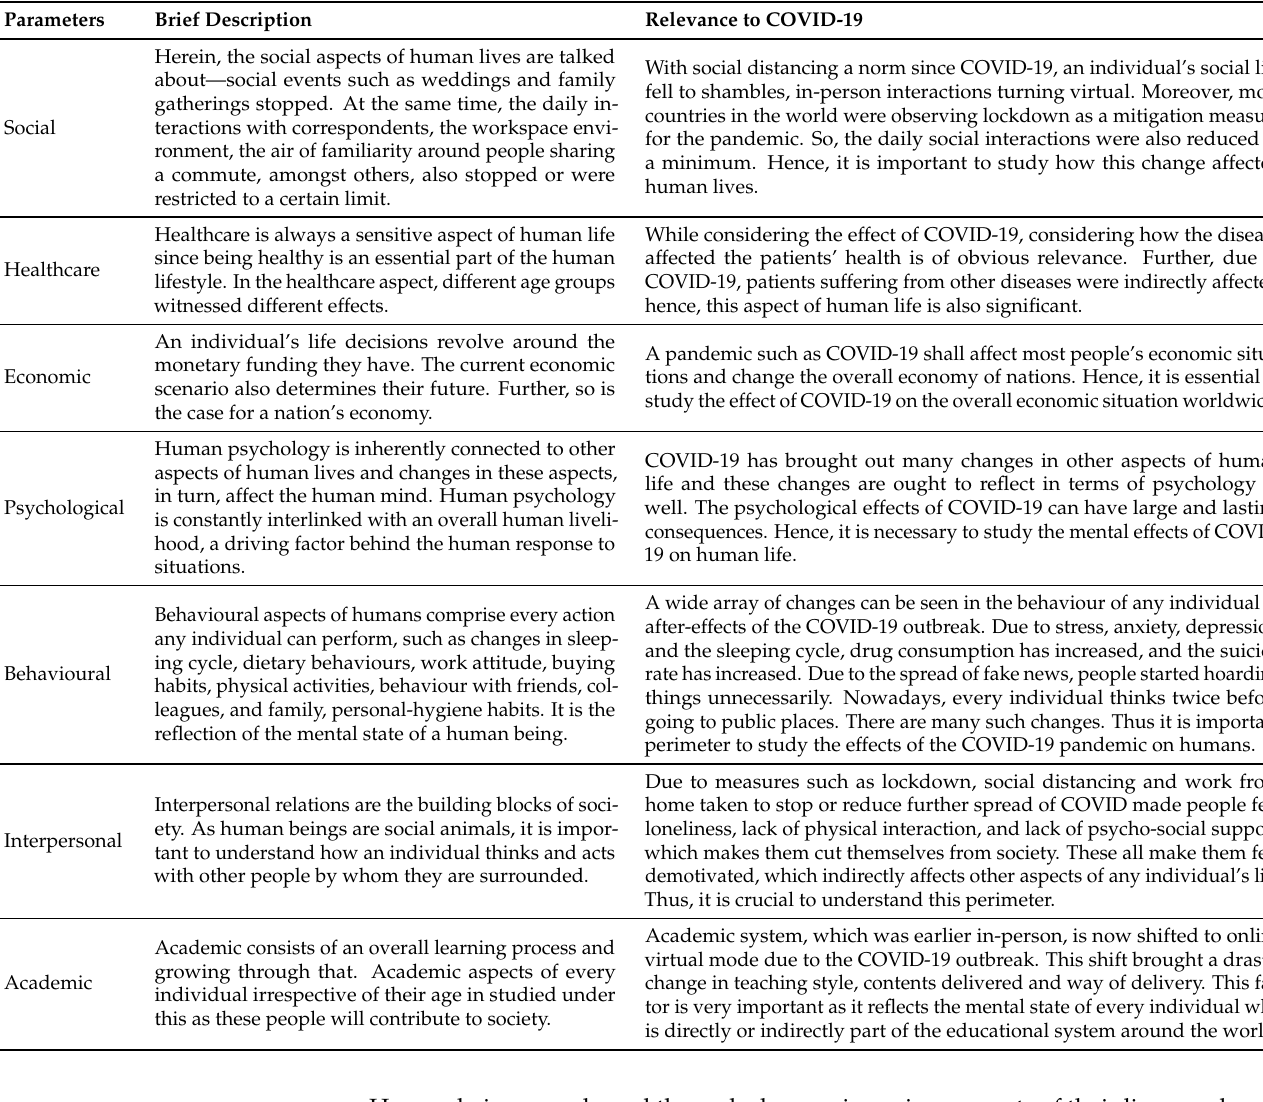
Table 4. Main effected areas of human